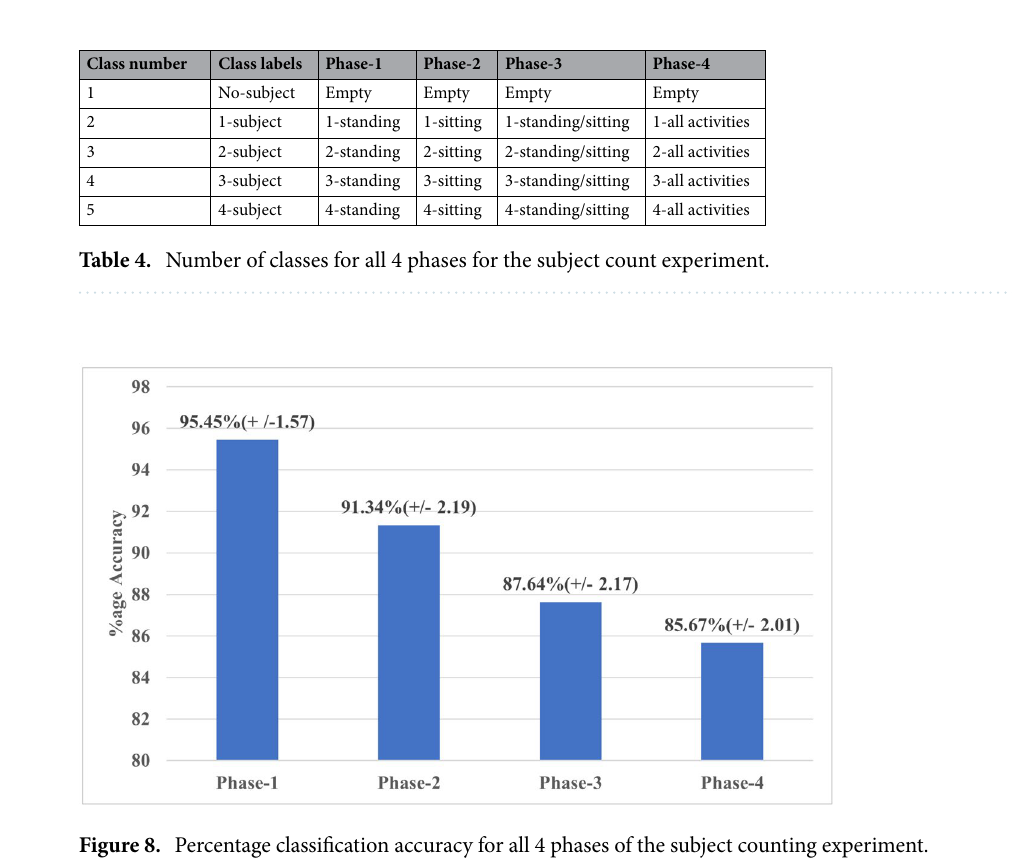
Figure 8. Percentage classification accuracy for all 4 phases of the subject counting